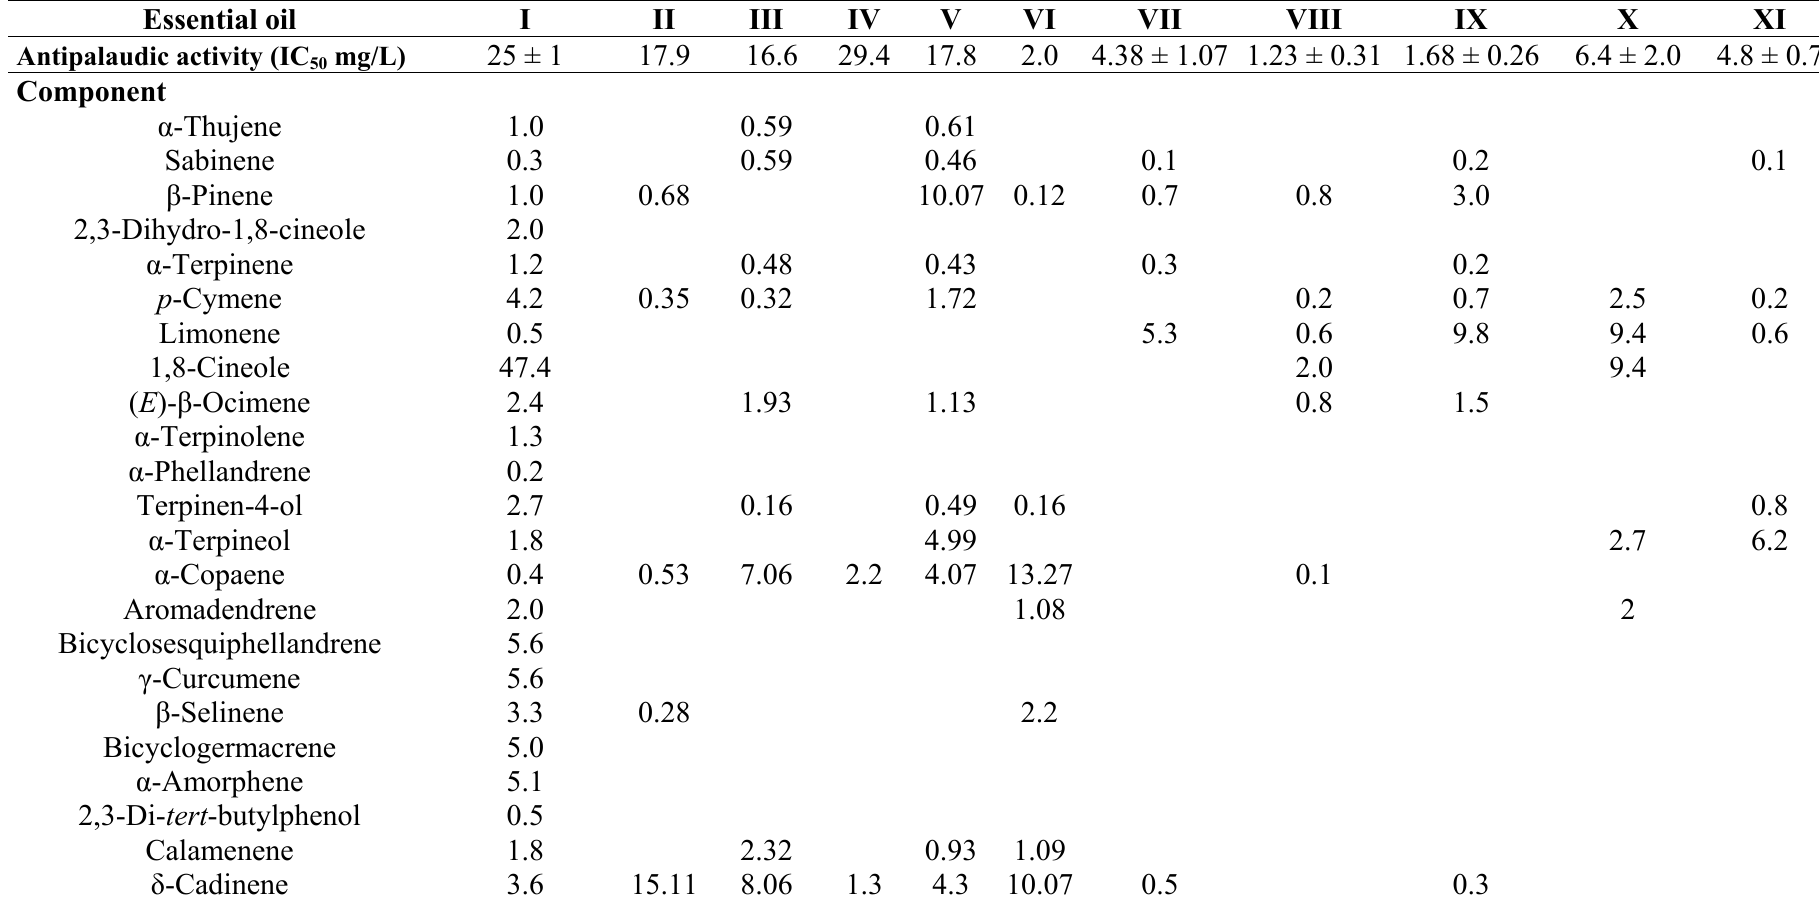
Table 4. Antipaludic activity and chemical composition of essential oils (I: Helichrysum gymnocephalum ; II: Xylopia phloiodora ; III: Pachypodanthium con fi ne ; IV: Antidesma laciniatum ; V: Xylopia aethiopica ; VI: Hexalobus crispi fl orus [40]; VII: Salvia stenophylla ; VIII: Salvia runcinata ; IX: Salvia repens [41]; X: Salvia albicaulis ; XI: Salvia dolomitica [42]; XII: Lippia multiflora [43]; XIII: Helichrysum cymosum [44]; XIV: Artemisia gorgonum Webb [45]; XV: Arnica longifolia ; XVI: Aster hesperius ; XVII: Chrysothamnus nauseosus